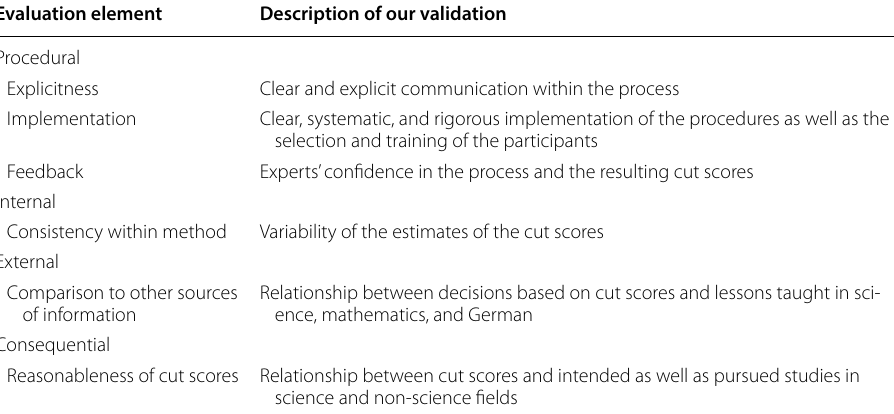
Table 1 Evaluation elements and aspects of standard-setting procedures. Adapted from Pant et al.